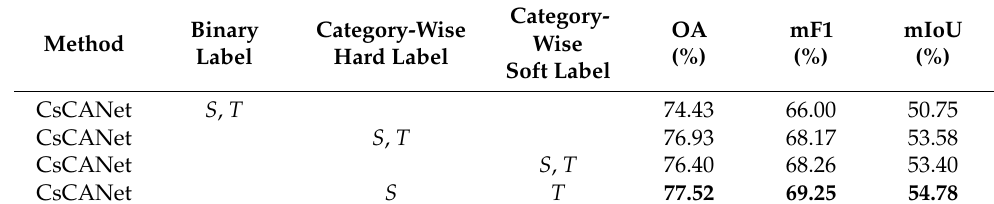
Table 6. Performance comparisons of CsCANet with different domain label extraction modules in evaluation metrics. S and T present the source and target domain. The best results are highlighted in bold.